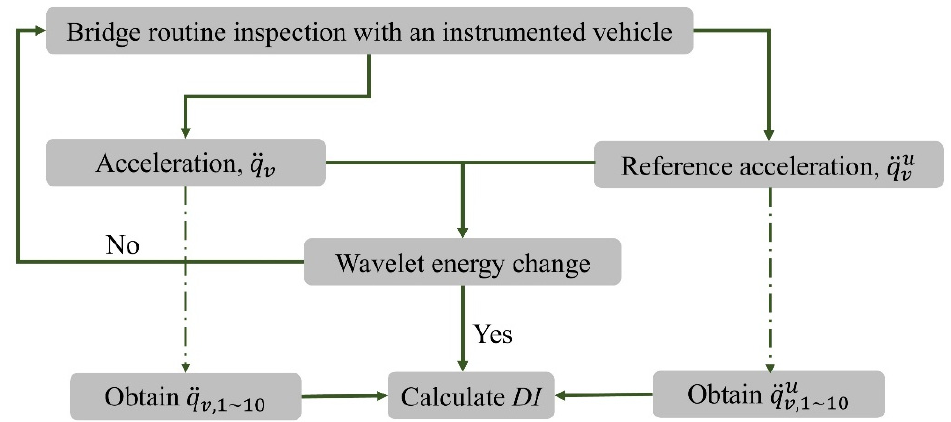
Figure 3. A flowchart for bridge damage detection.